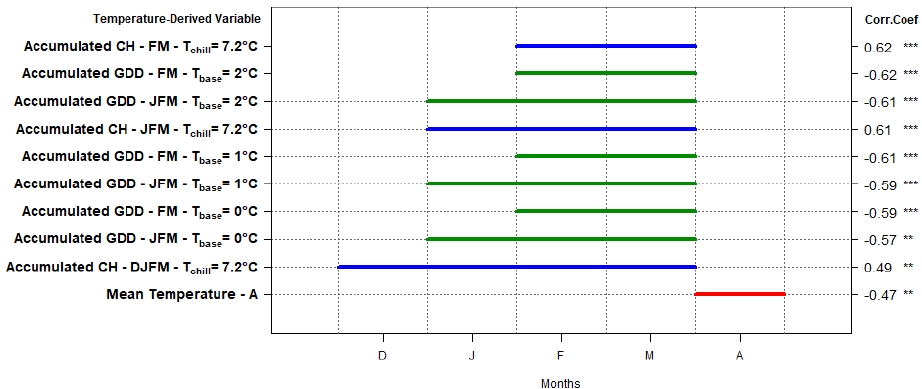
Figure 10. Significant correlations between the mean SOS trend and temperature-derived variables/intervals (*** p < 0.01, ** p < 0.05) ranked by correlation coefficients. CH = chill hours; GDD = growing degree days; D, J, F, M, and A stand for December, January, February, March, and April, respectively. Colored lines signify monthly intervals as line length shows the months included in the interval and colors show variable type as blue = CH, green = GDD, red = T mean.